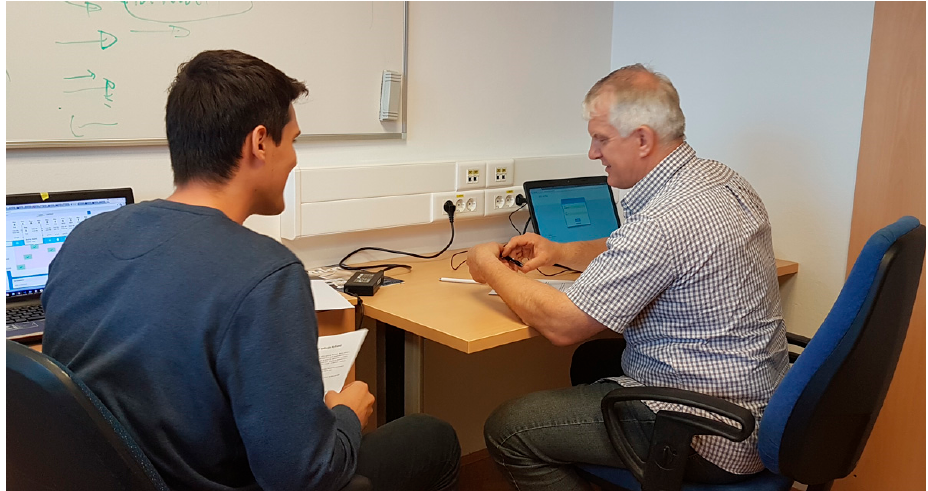
Figure A1. User interface of an interactive prototype solution translated into English.